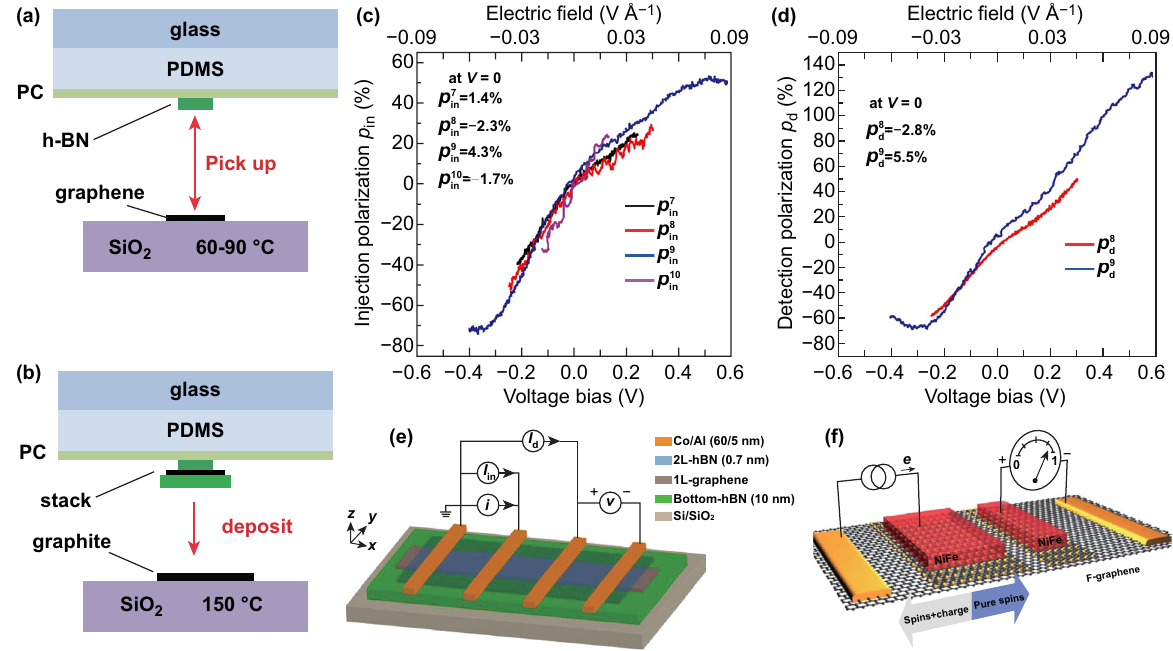
Fig. 3 a, b Diagram of the fast pickup technique. a Picking up process. b Depositing process [80]. c–e Experiment of bias‑induced differential spin injection ( p in ) and detection ( p d ) polarizations. c p in of four contacts, as a function of the DC voltage bias V . d p d for two different detector contacts, as a function of DC voltage bias V applied across the detector, while the injector bias is fixed at I in = + 20 μ A . e Schematic diagram of measuring device structure [83]. f Schematic image of the device in which the fluorinated graphene serves as a tunnel barrier [84]. Figures reproduced with permission from Refs. [80, 83,